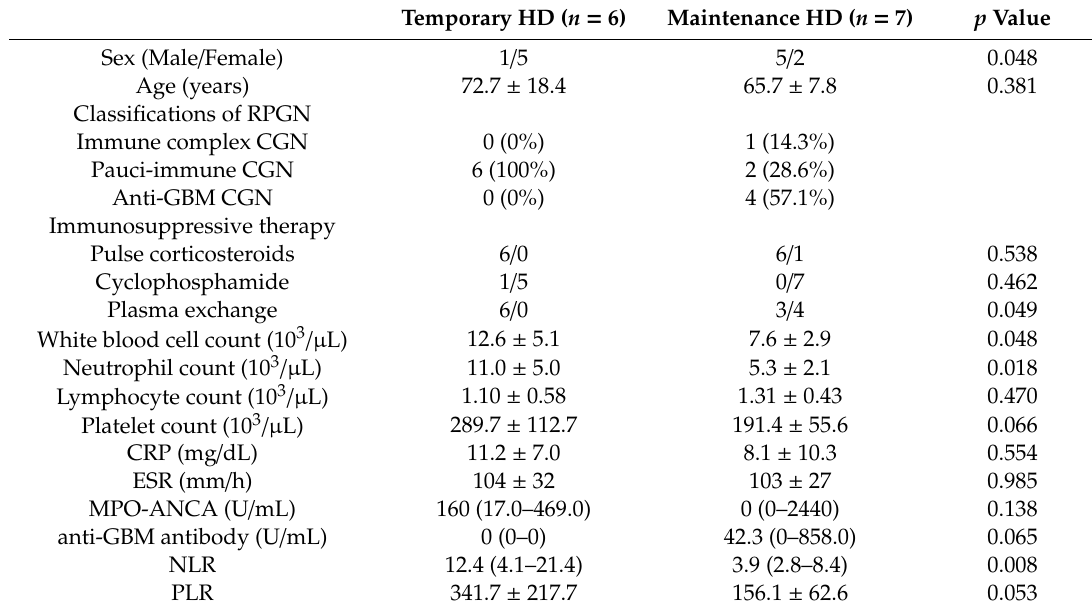
Table 2. Patient’s characteristics between temporary the HD and maintenance HD groups.